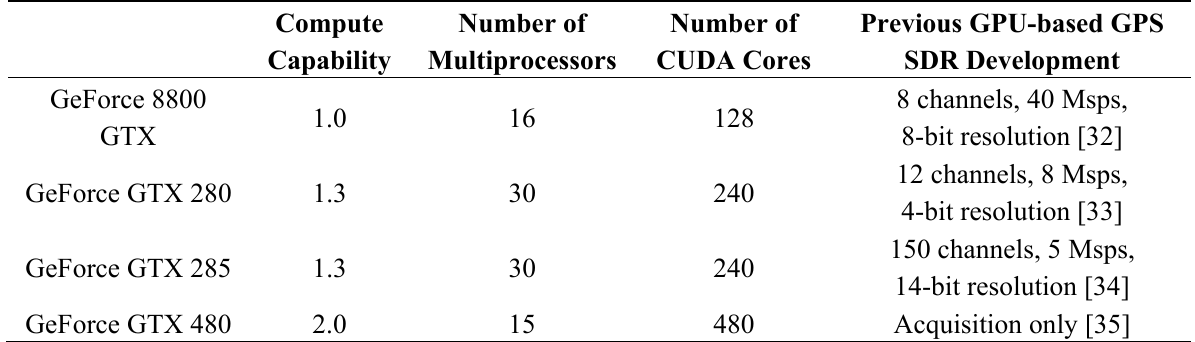
Table 1. Comparison of GPUs which have been used for GPS SDRs in the literature. The specifications of GPUs are selected from Table A-1 of